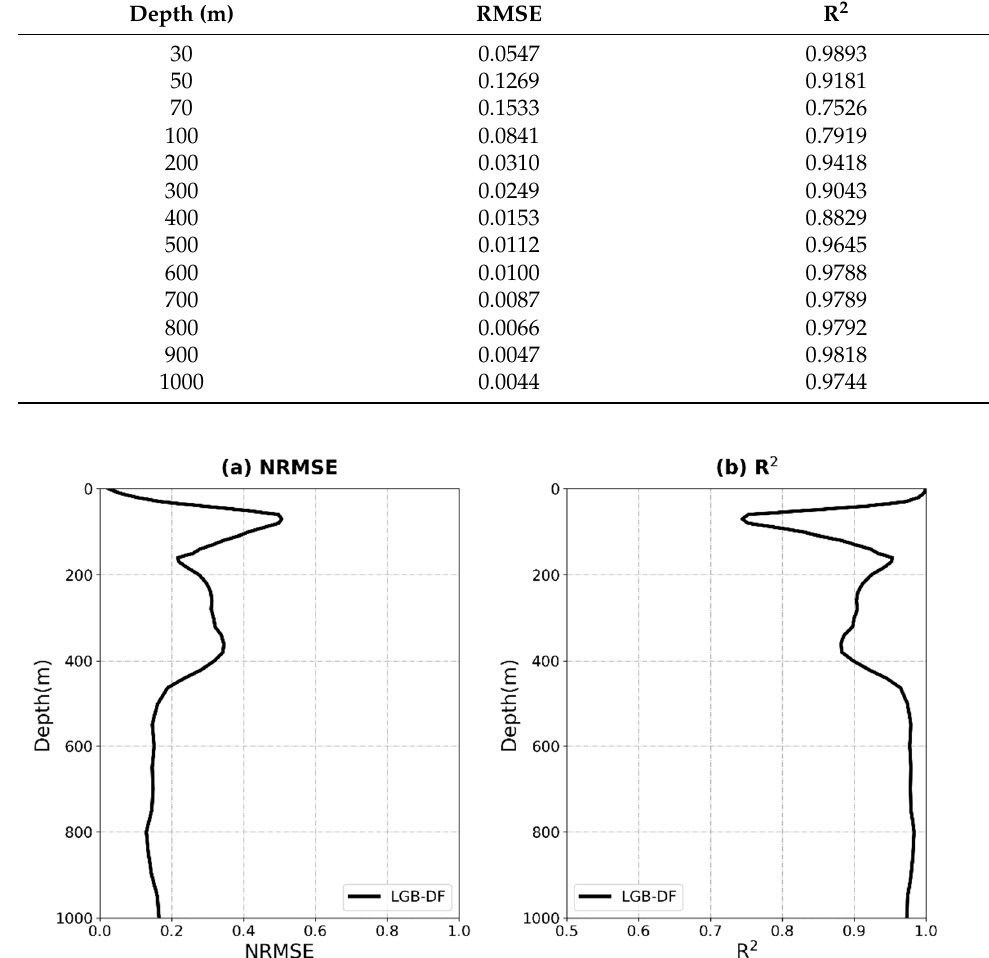
Figure 9. The estimation accuracy of OSSS in terms of NRMSE and R 2 at different depths by the LGB-DF model in 2019. LGB-DF model in